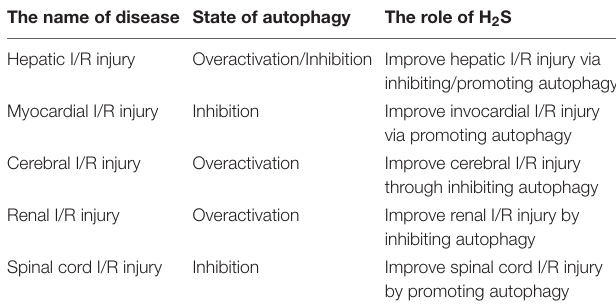
TABLE 1 | The effects of hydrogen sulfide (H 2 S) on autophagy in different ischemia/reperfusion (I/R)